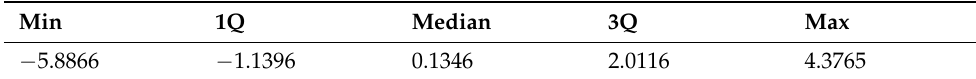
Table 4. Residual Values for the USL